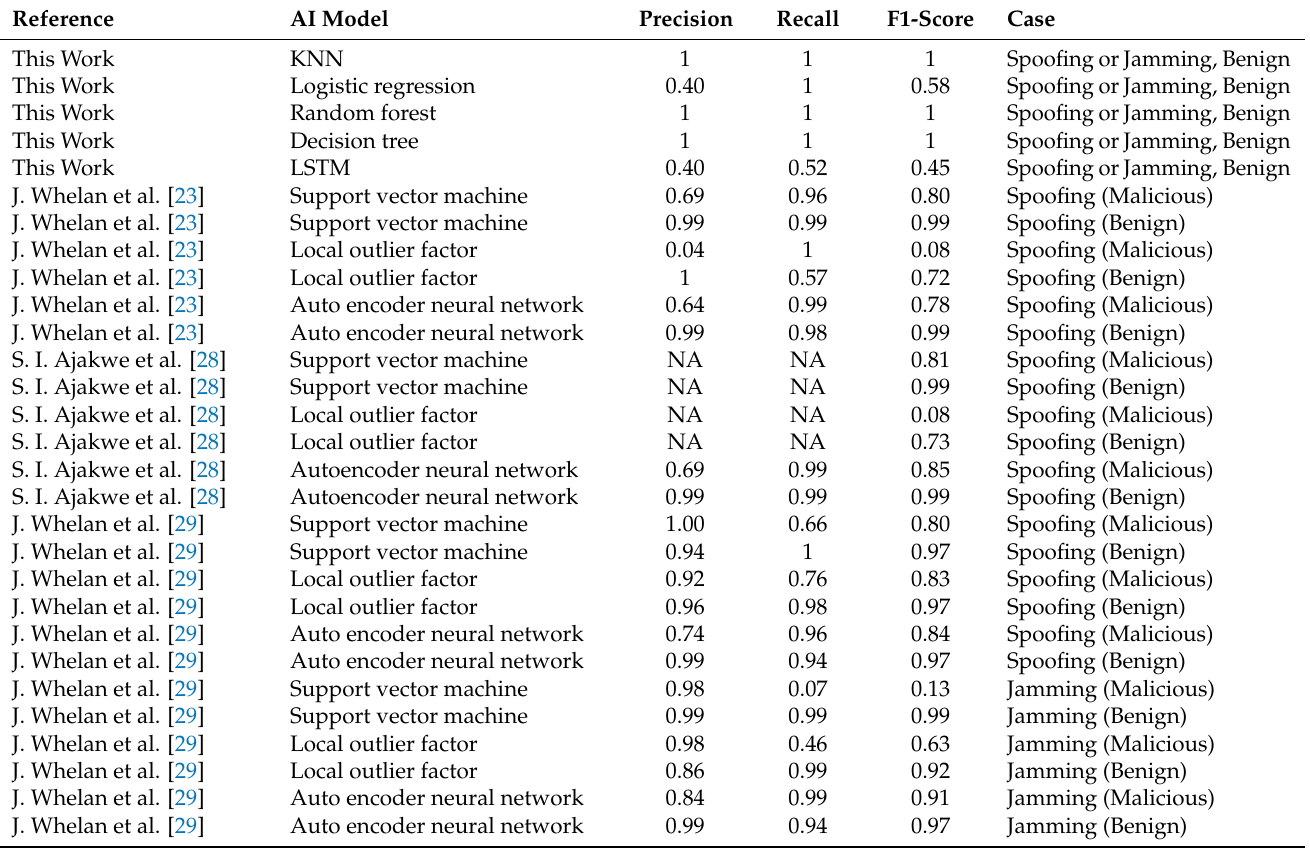
Table 3. Comparison between this work and the previous literature on attack